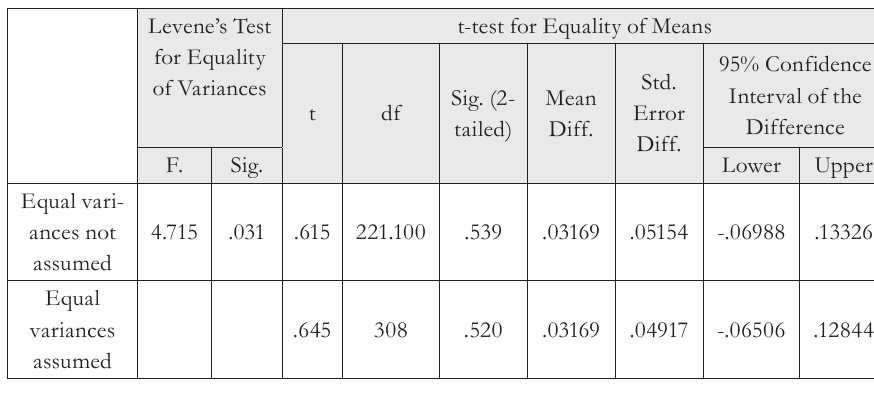
Tab. – 5 Productivity changes between 2008 and 2011 according to their changes in organisa- tional structure – test statistics. Source: Survey, CZSO, own